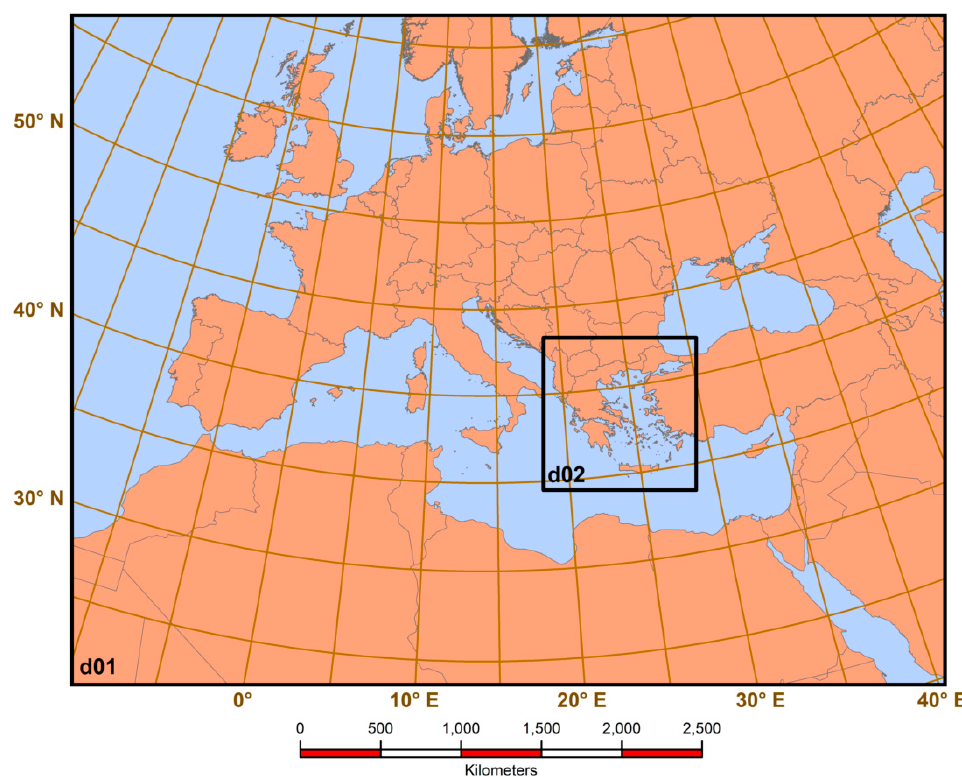
Figure 2. Weather Research and Forecasting ( WRF) model domains: d01-EU coarse domain with 20 km, and the innermost d02-GR domain covering Greece (5